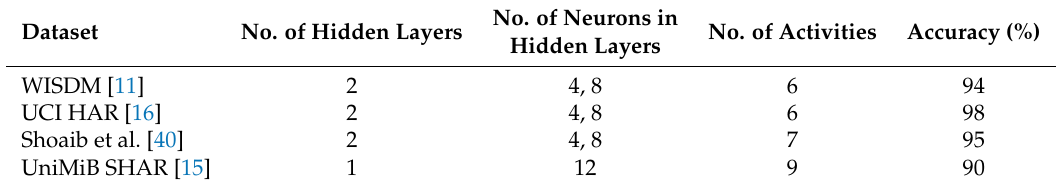
Table 8. Evaluation of the proposed neural network architecture with commonly used datasets.